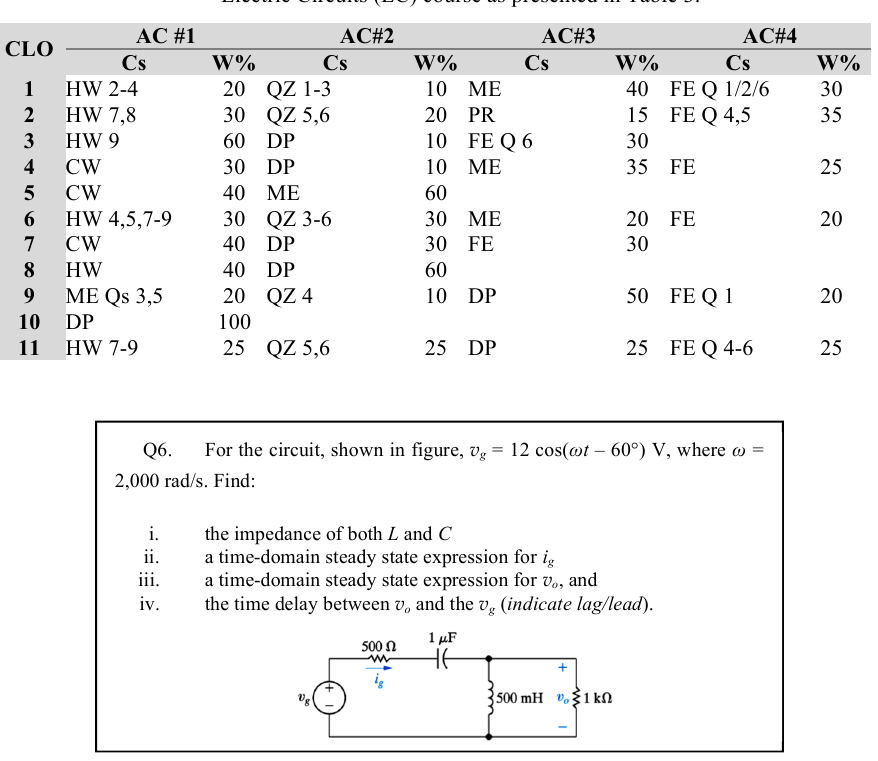
Fig. 2. Sample MEQ-6 component that maps onto CLOs 1, 3, and